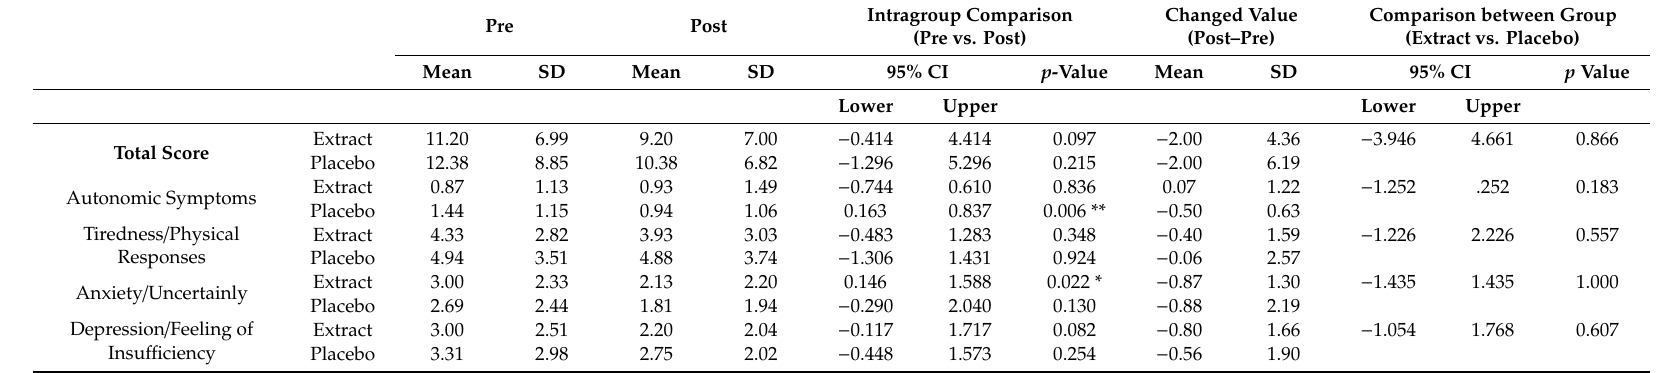
Table 4. Changes in stress responses between ES extract plus DR extract intake and placebo